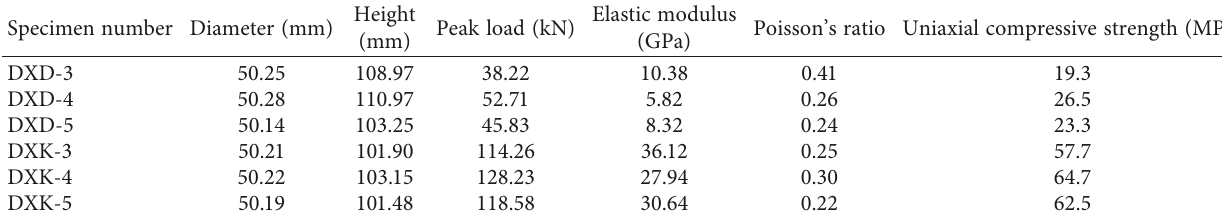
Table 2: Uniaxial compressive strength test results.